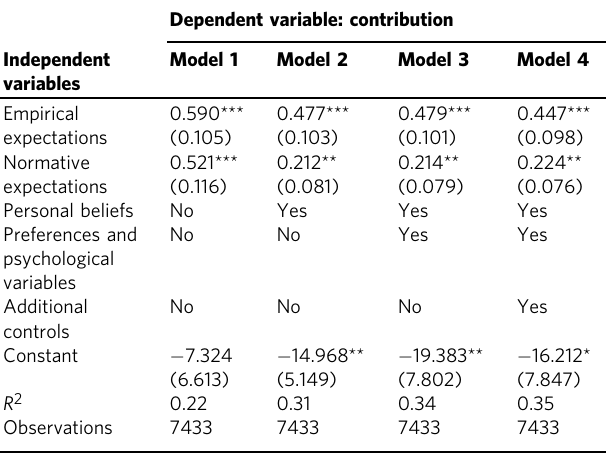
Linear regression model estimates with standard errors clustered according to 284 subjects. Statistical signi fi cance calculated using two-sided t -tests. Preferences and psychological variables contain social valueorientation, riskpreferences, AutismSpectrum Quotient, anda set of Big Five variables for extraversion, agreeableness, conscientiousness, neuroticism, and openness. Additional controls contain variables for treatment, collective risk, age, gender, student, experience with experiments, and left-right political orientation. * p <0.05, ** p <0.01, *** p